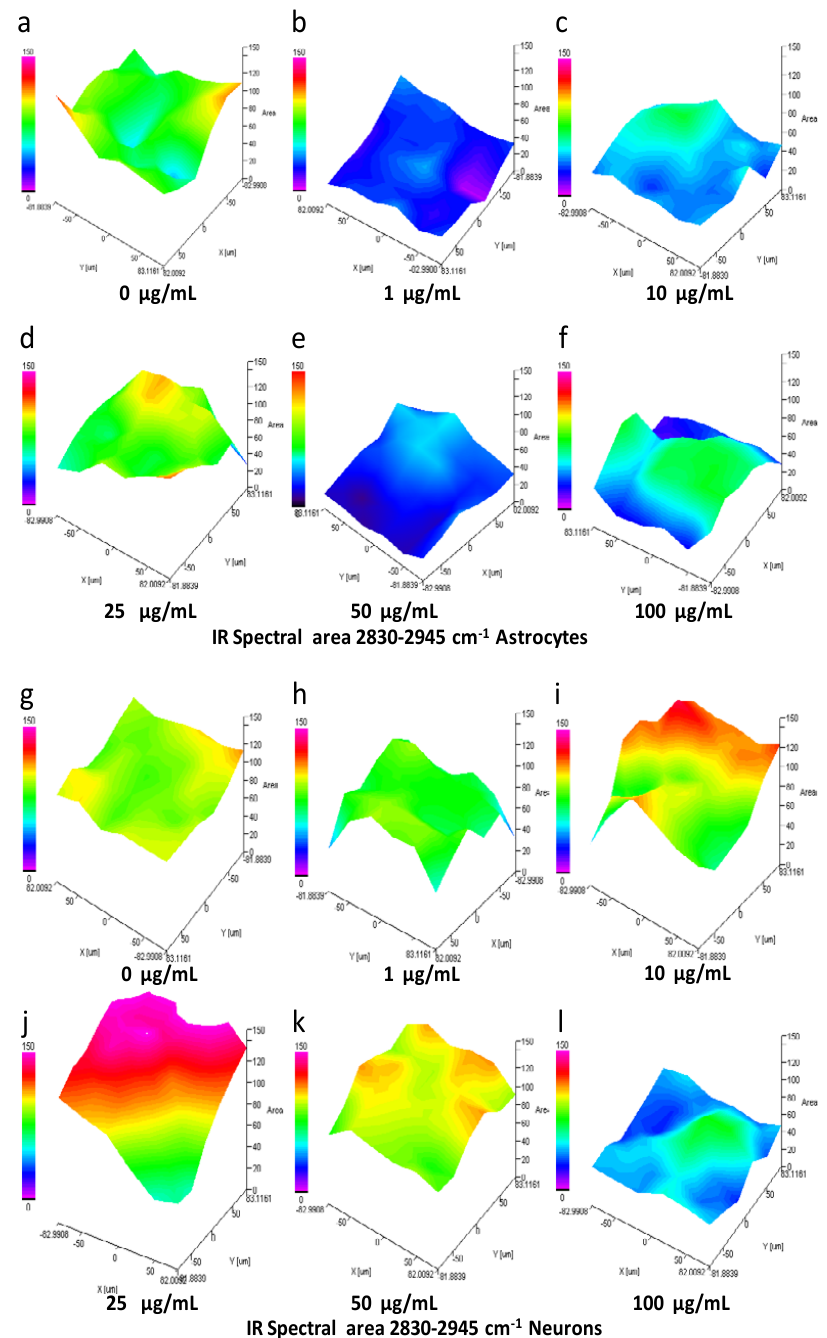
Figure 7. IQ mapping of IR spectral region 2830–2945 cm − 1 of astrocytes and neurons exposed to SiO 2 -NPs. The spectral region of 2830–2945 cm − 1 that includes specific spectral bands of symmetric and asymmetric vibrations of -CH 2 of lipids is presented for astrocytes ( a – f ) and neurons ( g – l ). A sample of cells treated with SiO 2 -NPs for 24 h was dispersed on a gold-coated slide. The three-dimensional image is presented in the x, y, and z axes, and the area presented as a gradient of color indicates a decrease (from blue) or increase (red) in the spectral signal. In astrocytes ( a – f ), a decrease in the signal (blue area) occurred at 1 ( b ), 10 ( c ), 50 ( e ), and 100 ( f ) µ g / mL of SiO 2 -NPs when compared to control ( a ). No changes were observed at 25 µ g / mL ( d ). In neurons ( g – l ) , spectral signal increased (red area) from 1–50 µ g / mL ( h – k ) when compared to control ( g ). The higher increase in signal was detected at 25 µ g / mL ( j ). On the contrary, at the concentration of 100 µ g / mL ( l ), the lowest spectral signal was detected. The image is representative of four independent experiments with three technical